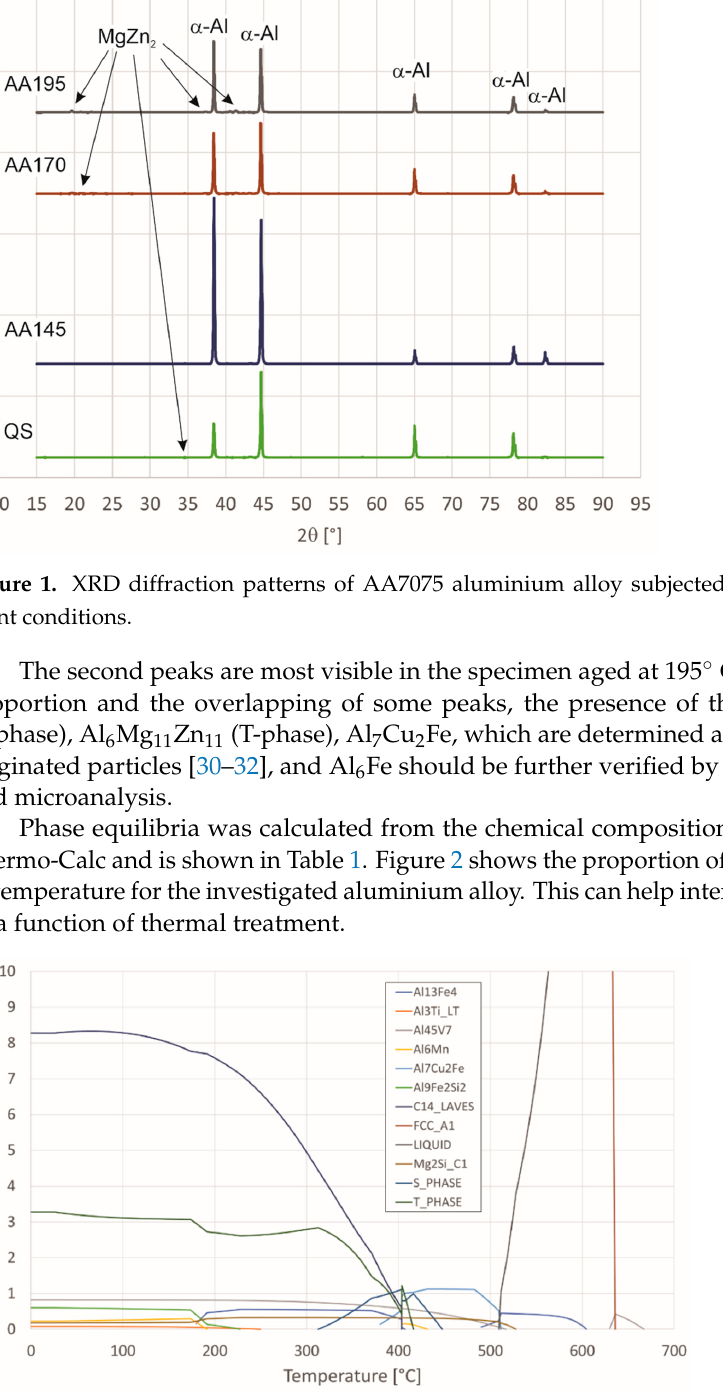
Figure 2. Proportion of phases as a function of temperature.